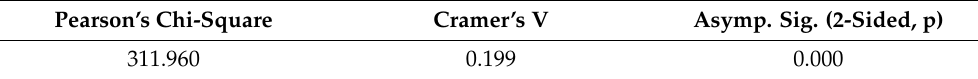
Table 4. The statistical relationship values for relation between age of students and environmental education. Pearson’s Chi-Square